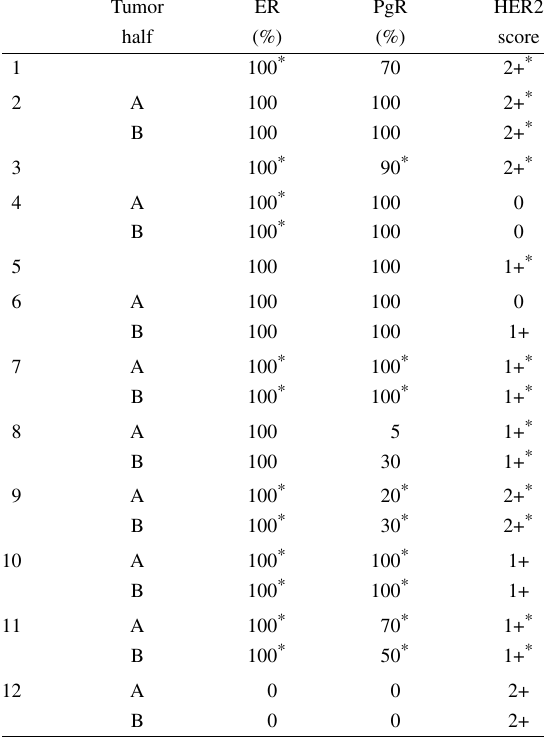
Immunohistochemical analysis of the protein expression of ER, PgR and HER2 for the two tumor halves (A and B) of each patient